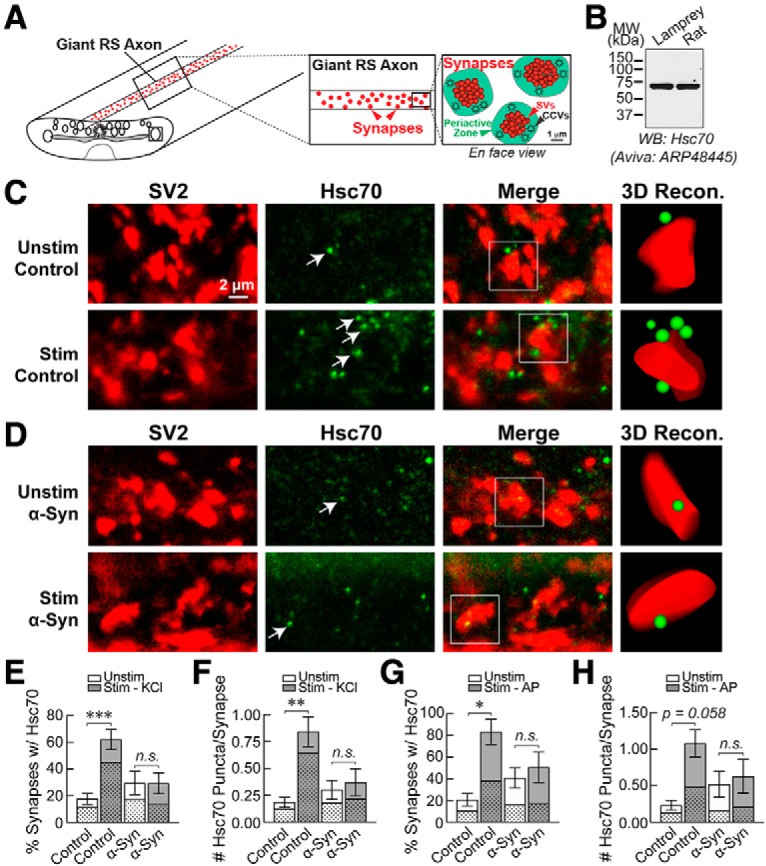
Excess α-synuclein inhibits Hsc70 availability at lamprey synapses. A, Diagram showing the basic organization of the giant RS synapses within lamprey spinal cord. The large synaptic vesicle (SV) clusters (red) are surrounded by a distinct periactive zone where CME occurs (green). B, By Western blotting, the Hsc70 antibody used for these experiments (Aviva ARP48445) specifically recognized a single band at 70 kDa in both lamprey CNS and rat brain lysates, consistent with the expected molecular weight of Hsc70. C, Confocal images showing clusters of giant synapses immunostained for the synaptic vesicle-associated protein SV2 (red) and Hsc70 (green). Compared to unstimulated conditions, stimulation with high K+ increased Hsc70 availability at synapses, as evidenced by an increase in the number of visible Hsc70 puncta (arrows). D, In contrast, α-synuclein inhibited the stimulation-dependent increase in Hsc70 at synapses. E, F, Graphs showing the percentage of synapses (per axon) with associated Hsc70 puncta, as well as the average number of Hsc70 puncta per synapse. Bars represent mean ± SEM from n = 76–135 synapses, n = 5–13 axons, n = 5–7 animals/condition; *p < 0.05, **p < 0.01, ***p < 0.001, ****p < 0.0001; n.s. = not significant by ANOVA. G, H, Similar results were obtained using action potential stimulation (20 Hz, 5 min) and a different Hsc70 antibody (Enzo Life Sciences SPA815). Bars represent mean ± SEM from n = 31–47 synapses, n = 3–4 axons, n = 2–3 animals/condition; *p < 0.05, **p < 0.01; n.s. = not significant by ANOVA. In panels E–H, the stippled regions of the bars represent the proportion of Hsc70 puncta overlapping or touching the SV cluster, while the clear regions indicate the proportion localized within the periactive zone.